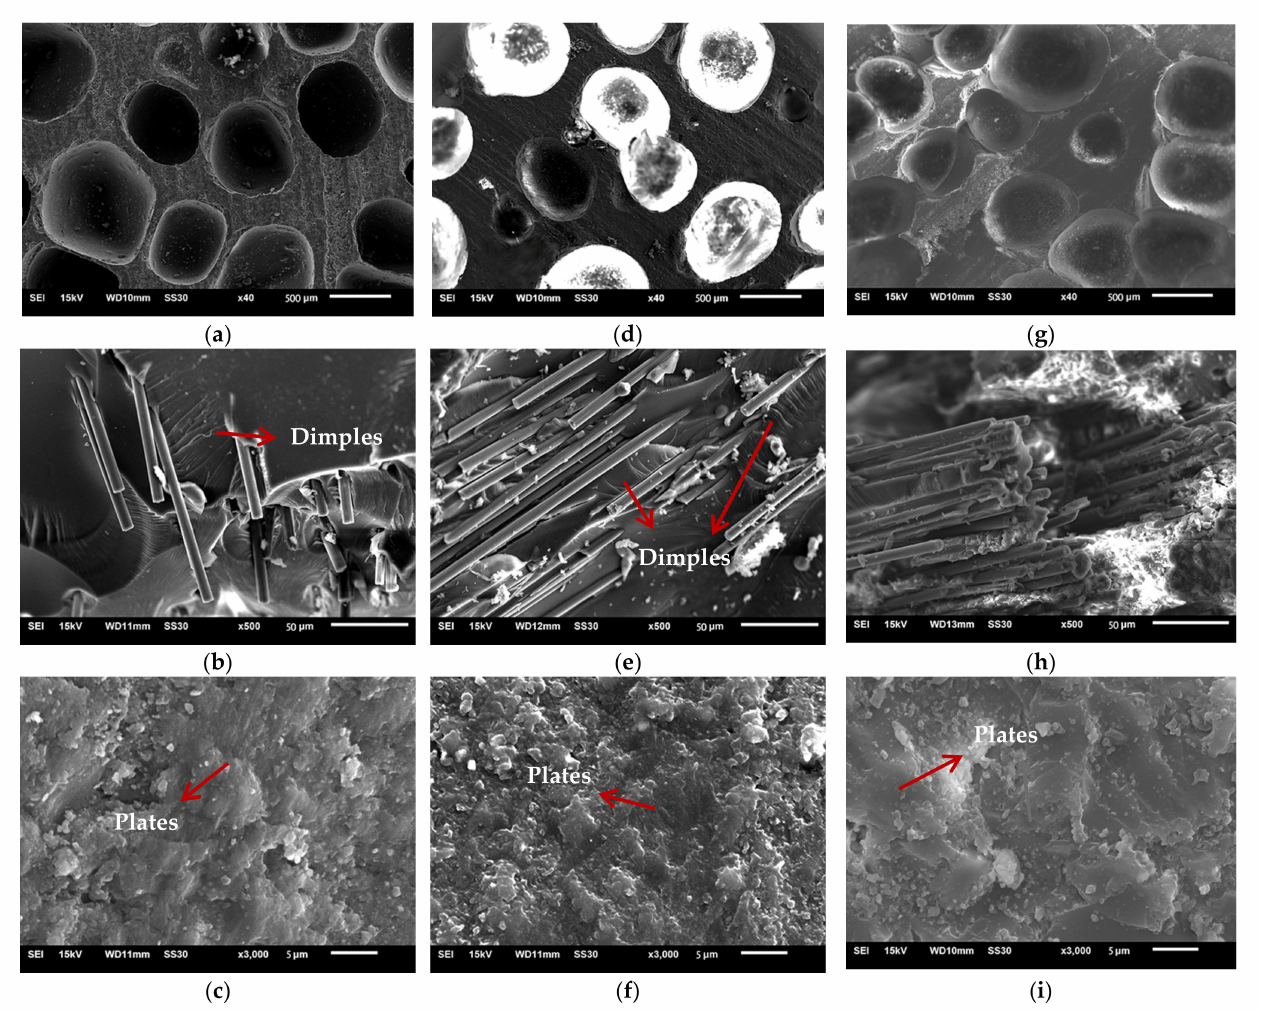
Figure 12. SEM micrographs of cured CCFR-LDUPR sample in the presence of 1.00 phr chopped carbon fibers ( a – c ), cured CCFR-LDUPR sample in the presence of 3.00 phr chopped carbon fibers ( d – f ), and cured CCFR-LDUPR sample in the presence of 5.00 phr chopped carbon fibers ( g – i